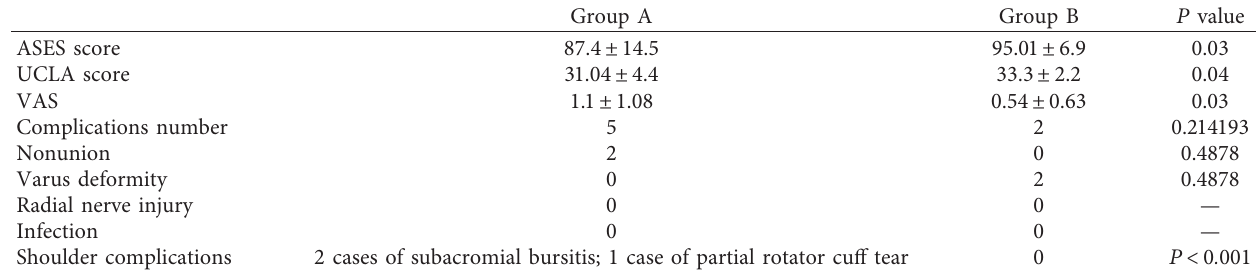
Figure 2: A 41-year-old female patient had humeral diaphyseal fracture due to a car accident. Preoperative X-ray shows AO/OTA type 12-B (a). She was treated by MIPO technique with complete fracture union as shown in 5 months postoperative X-ray (b, c). The patient had full shoulder function and complete range of motion (d, e). Table 2: The final results of shoulder scores and complications for both